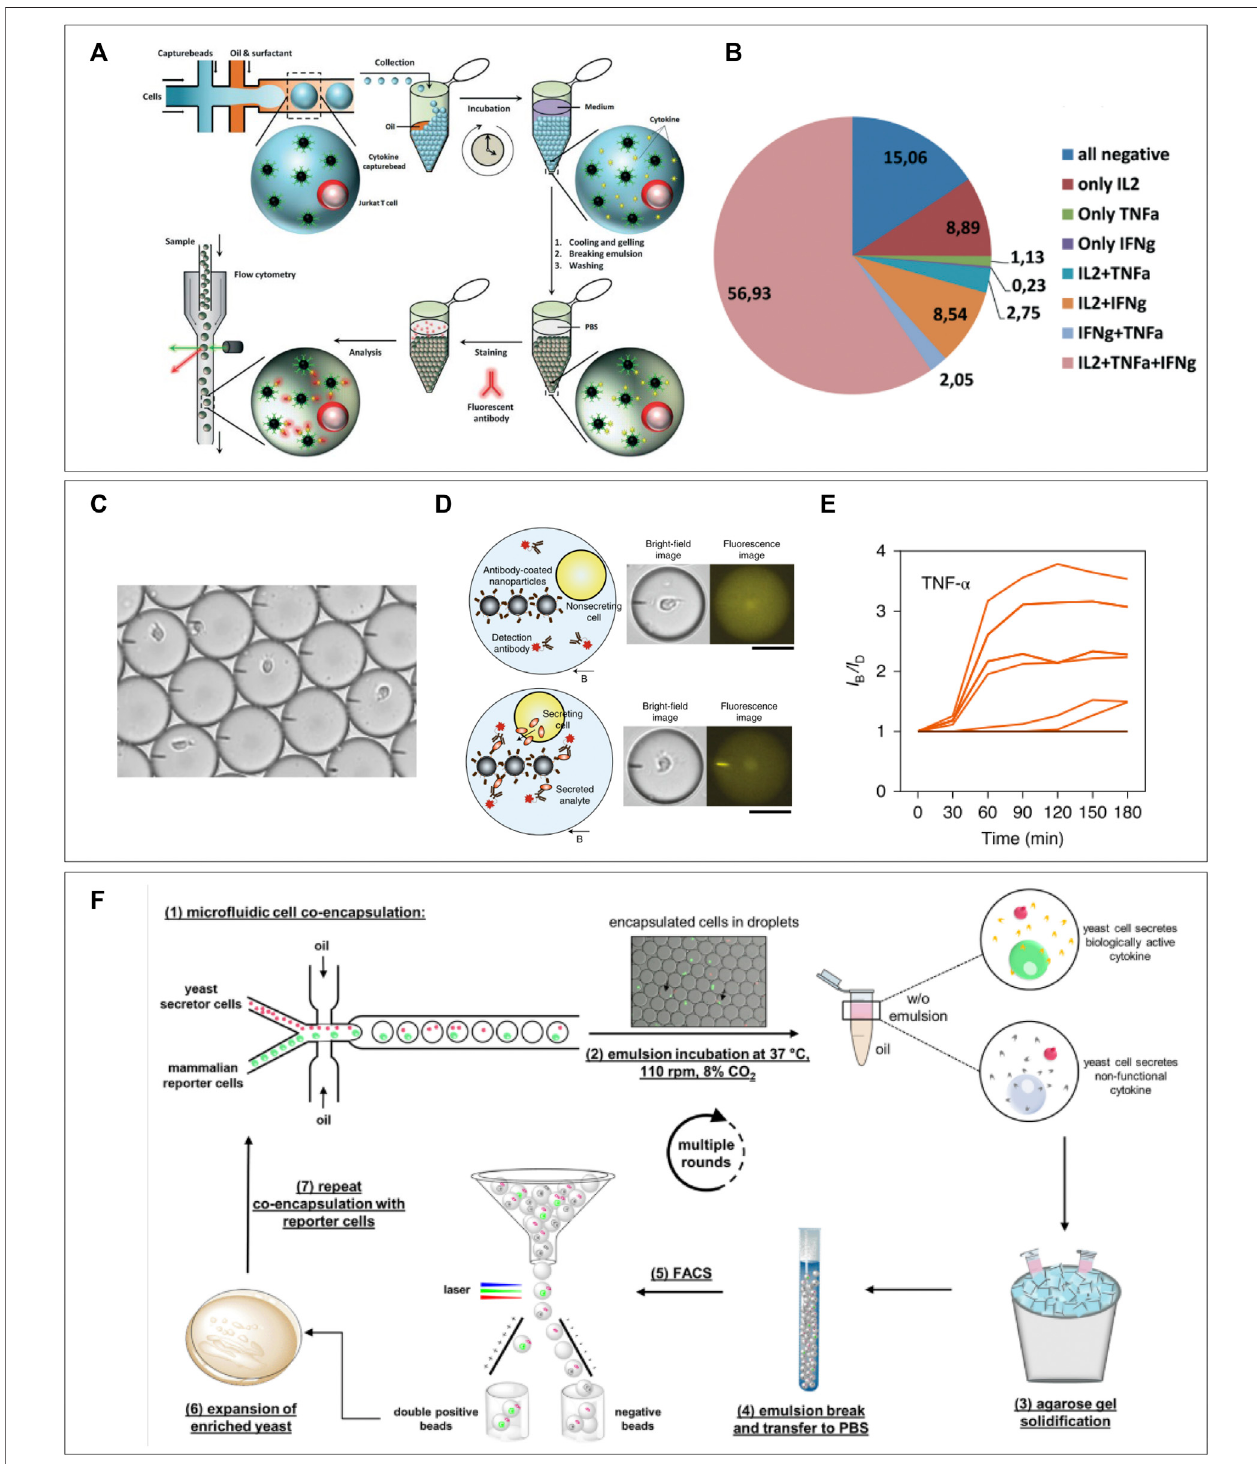
FIGURE6| Cell-reporterpairingforimmuneassays. (A) Capturebeadsspeci fi cforthreedifferentcytokinesareco-encapsulatedinhydrogeldroplets,aftergelation and emulsion breaking the whole droplet can be stained for captured cytokines and measured using fl ow cytometry. (B) Secretional heterogeneity of Jurkat T cells can be detected using this method ofmultiparameter single-cell cytokine detection (Chokkalingam et al.,2013). (C) Bead-line encapsulation evades the Poissondistribution as every droplet will contain around 1,000 nm-sized capture beads. (D) Cellular cytokine secretion can be observed and (E) quanti fi ed over time by measuring translocation of co-encapsulated fl uorescent antibodies (Bounab et al., 2020). (F) Yeast cells are co-encapsulated with murine IL-3 reporter cells. Gelation of droplets and de-emulsi fi cation allows fl ow cytometric sorting of IL-3 producing yeast cells. Expansion and repeating of procedure allows enrichment of secreting yeast cells (Yanakieva et al.,